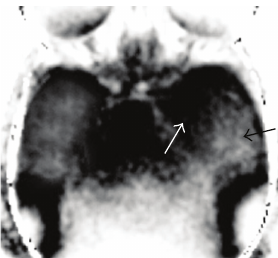
Figure 11: 48h R2 (cid:2) map shows significant low signal of infarcted core (white arrow), high signal of IP (black arrow) (Figures 9, 10, and 11 is same animal as Figures 5, 6, and 7).